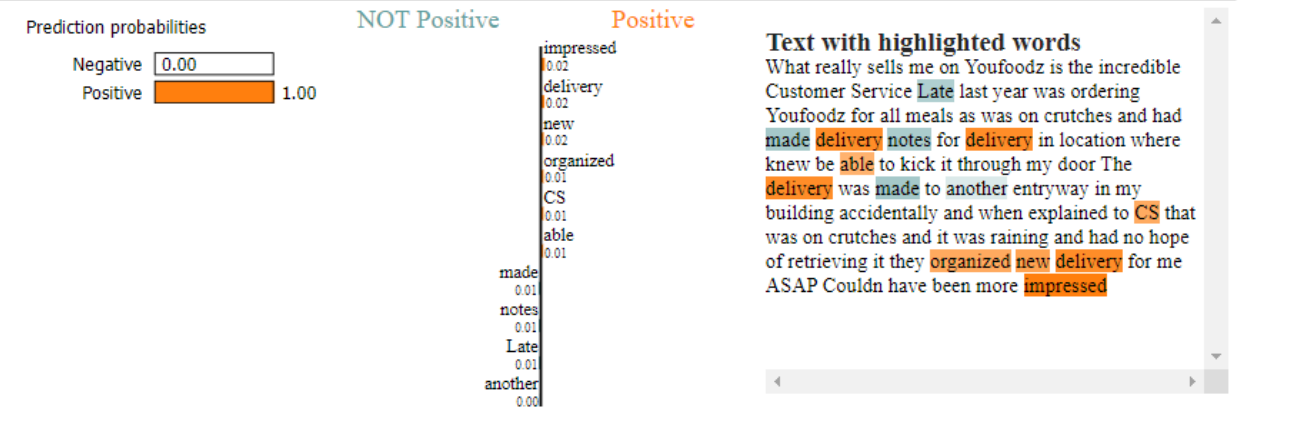
Figure 8. LIME explanation of the positive customer review detected by the LSTM model.